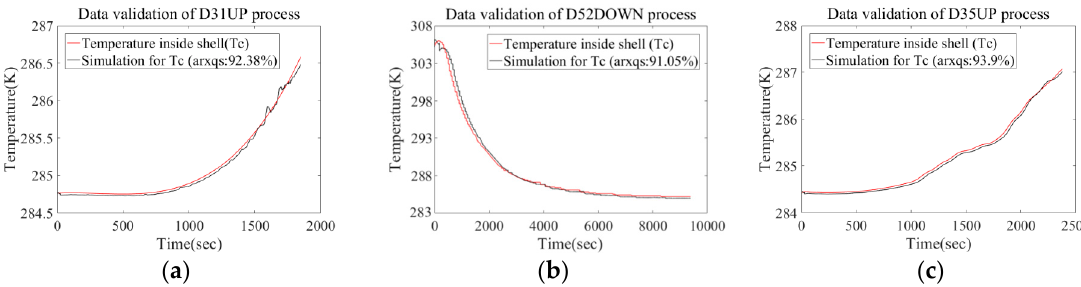
Figure 5. Comparison between real measurement and prediction data group ( T c - T s ). ( a ) Comparison for floating profile process of #31 ROV task. ( b ) Comparison for diving profile process of #52 ROV task. ( c ) Comparison for floating profile process of #35 ROV task. Sensors 2018 , 18 , x FOR PEER REVIEW